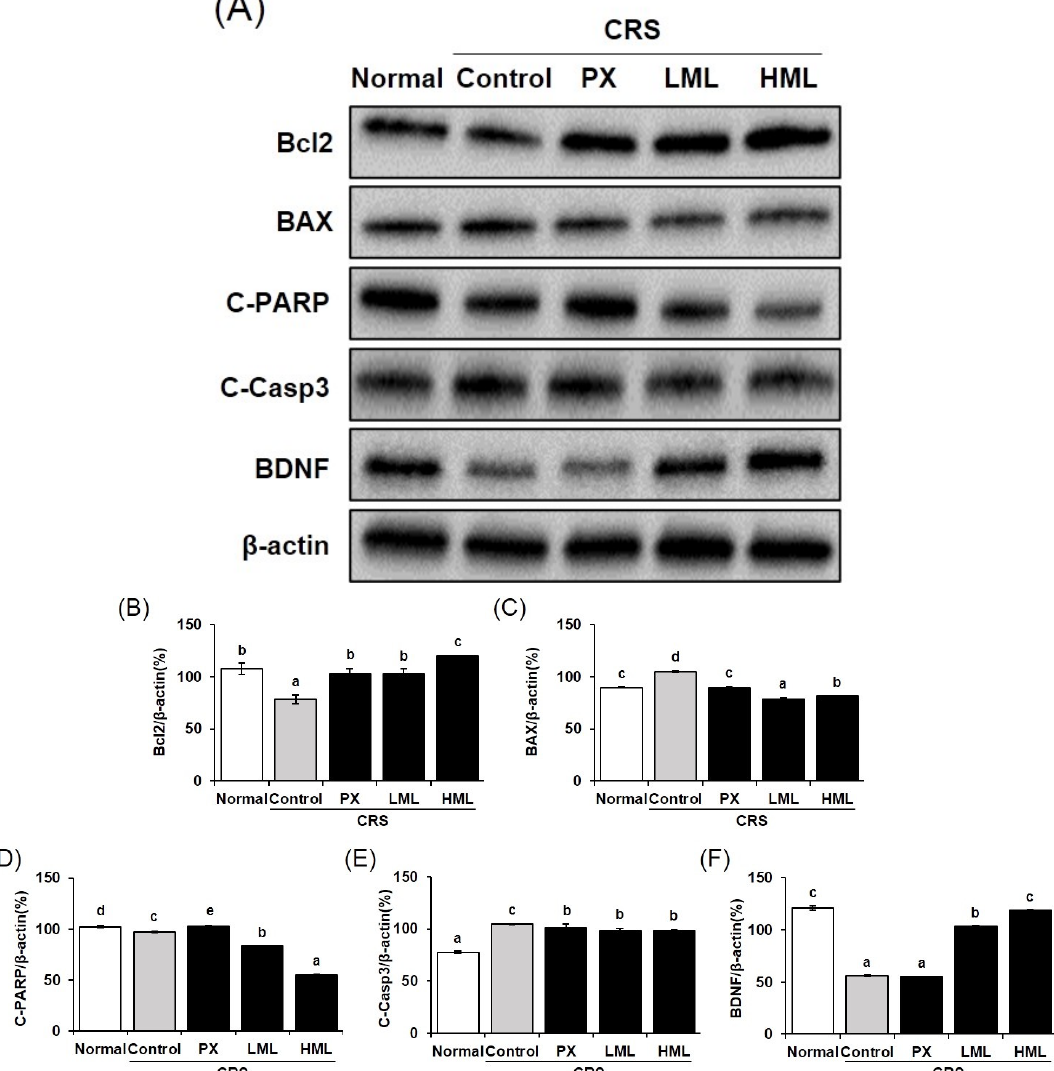
Figure 6. E ff ects of the ML extracts on the expression of BDNF and apoptosis-related proteins in brain tissue. ( A ) BDNF and apoptosis-related proteins were detected by Western blot. ( B – F ) densitometry analysis of